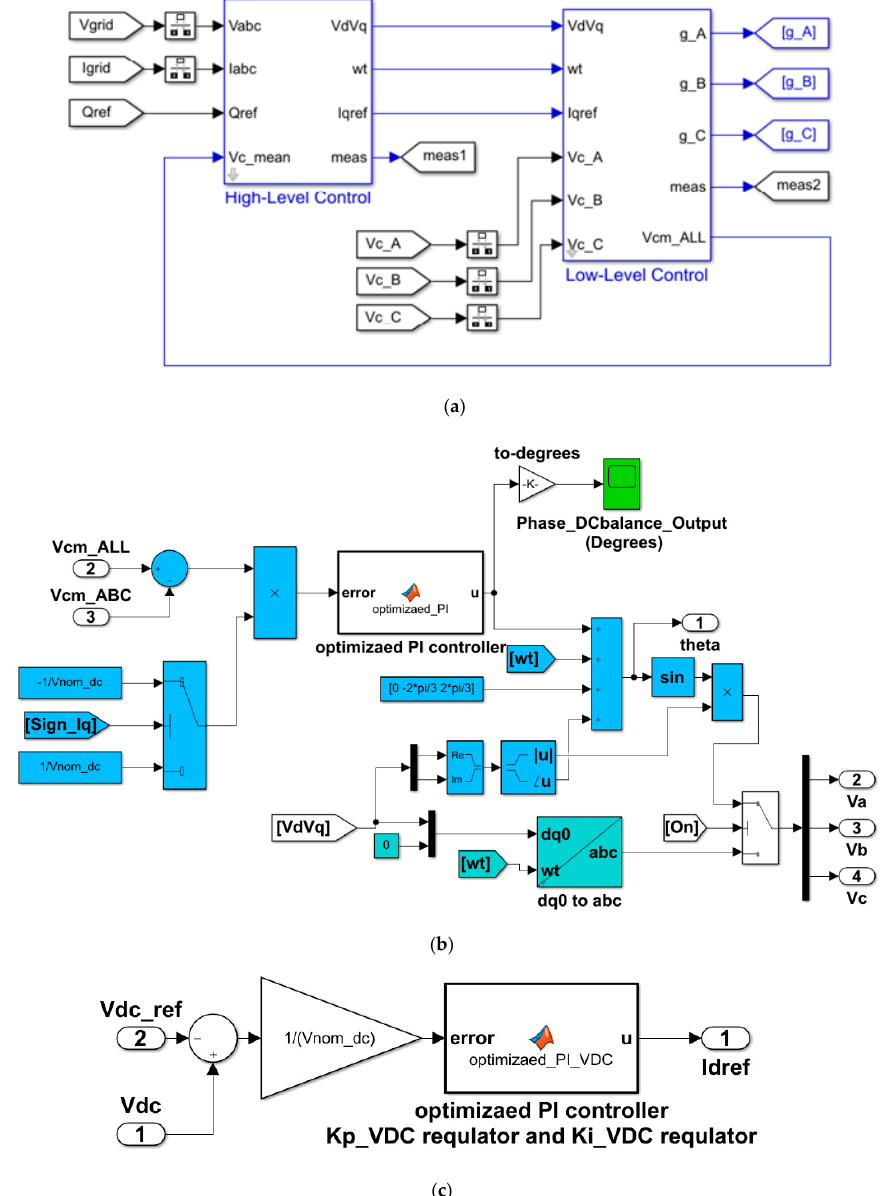
Figure 10. The controller of the MMC converter: ( a ) Simulink configuration; ( b ) An optimized controller for phase balancing based on the Harris hawk’s optimization (HHO) or Atom search optimization (ASO) optimization techniques; ( c ) An optimized controller of DC voltage based on the HHO or ASO optimization techniques. Table 2. Parameters of the studied network.